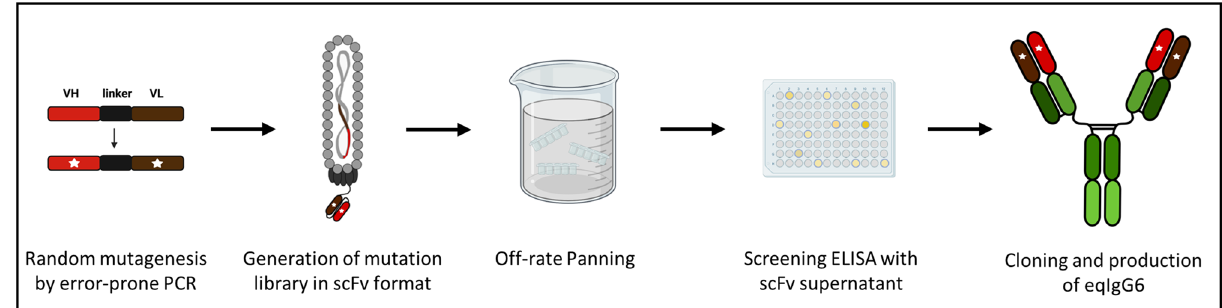
Figure 5. Process of in vitro affinity